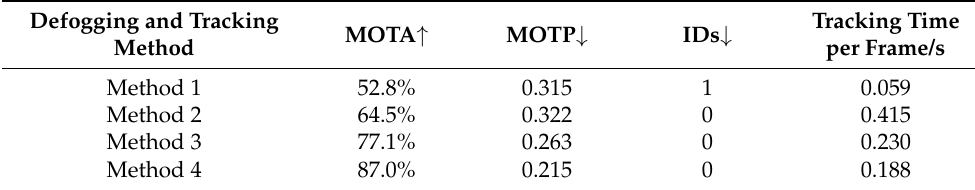
Table 5. Multiobject tracking indexes with different